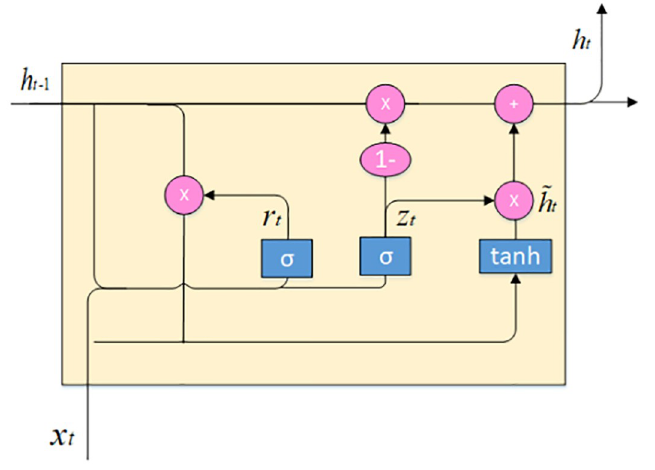
Fig 2. Gated recurrent unit